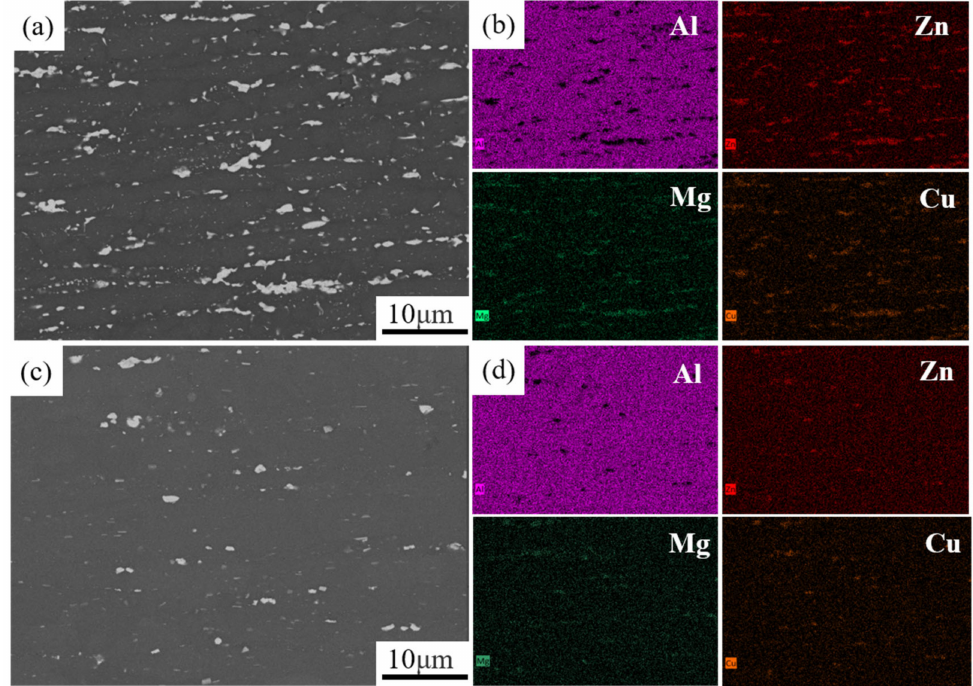
Figure 1. ( a , b ) Microstructure of the Al-Zn-Mg-Cu alloy at the extruded state and the elemental map analysis; ( c , d ) microstructure of the Al-Zn-Mg-Cu alloy at the overaged state.